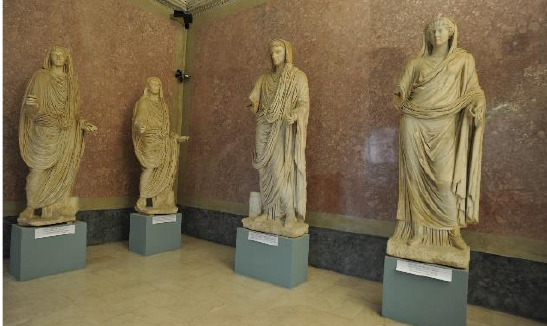
Figure 1. The Giulio-Claudio statuary exhibited in the Archaeological Museum of